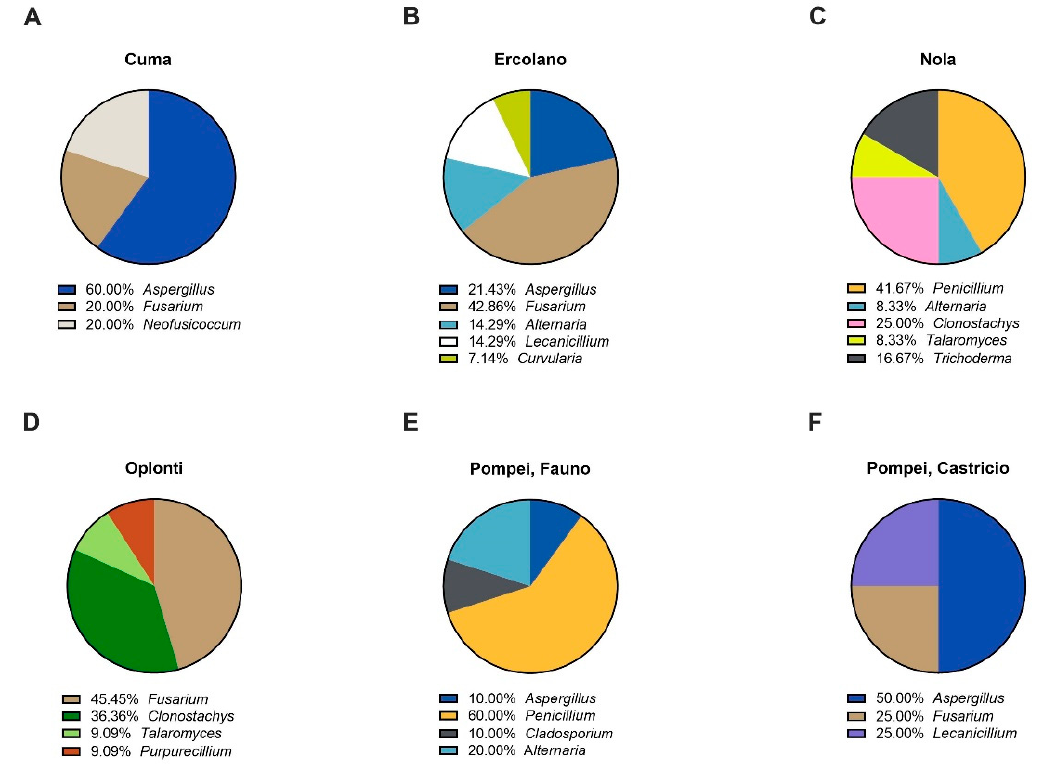
Figure 4. The relative prevalence of fungal genera found in: Sibyl Caves in Cuma ( A ), Suburban Baths in Ercolano ( B ), the Roman Amphitheater in Nola ( C ), the House of Poppea in Oplonti ( D ), and the House of Fauno ( E ) and the House of Castricio ( F ) in Pompei.